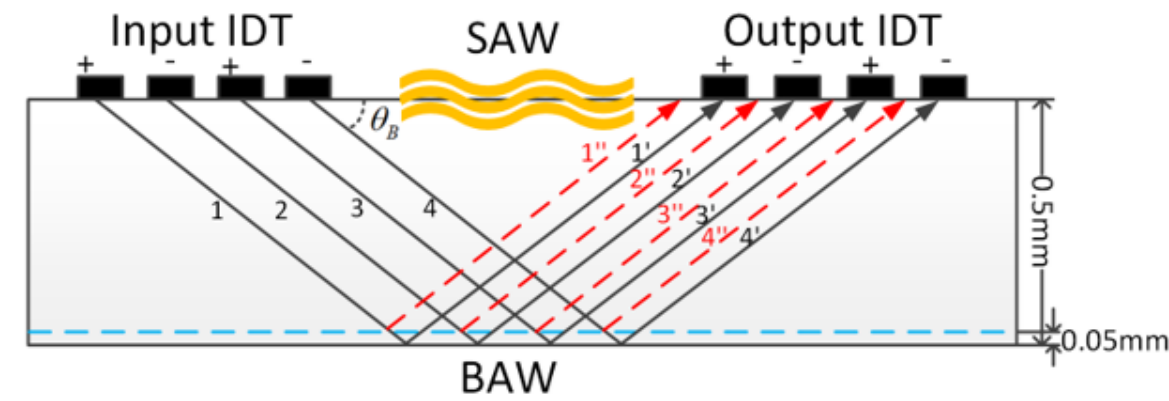
Figure 3. Change in BAW reflection excited by IDT by engraving bi − directional slots.